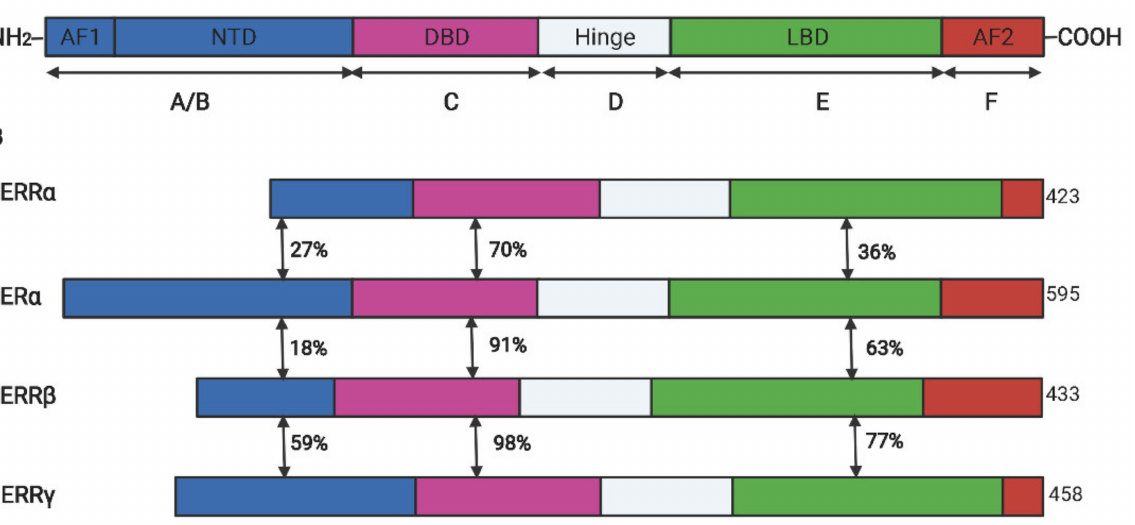
Figure 1. The schematic diagram for the protein domains of ER α and ERR isoforms. ( A ). The conserved structure of nuclear receptors. ( B ). The domain similarity between ERRs and ER α . DBD, DNA binding domain; LBD, ligand binding domain; AF, activation functional domain; NTD, N- terminal domain; The double-headed arrows indicated the sequence similarity between two